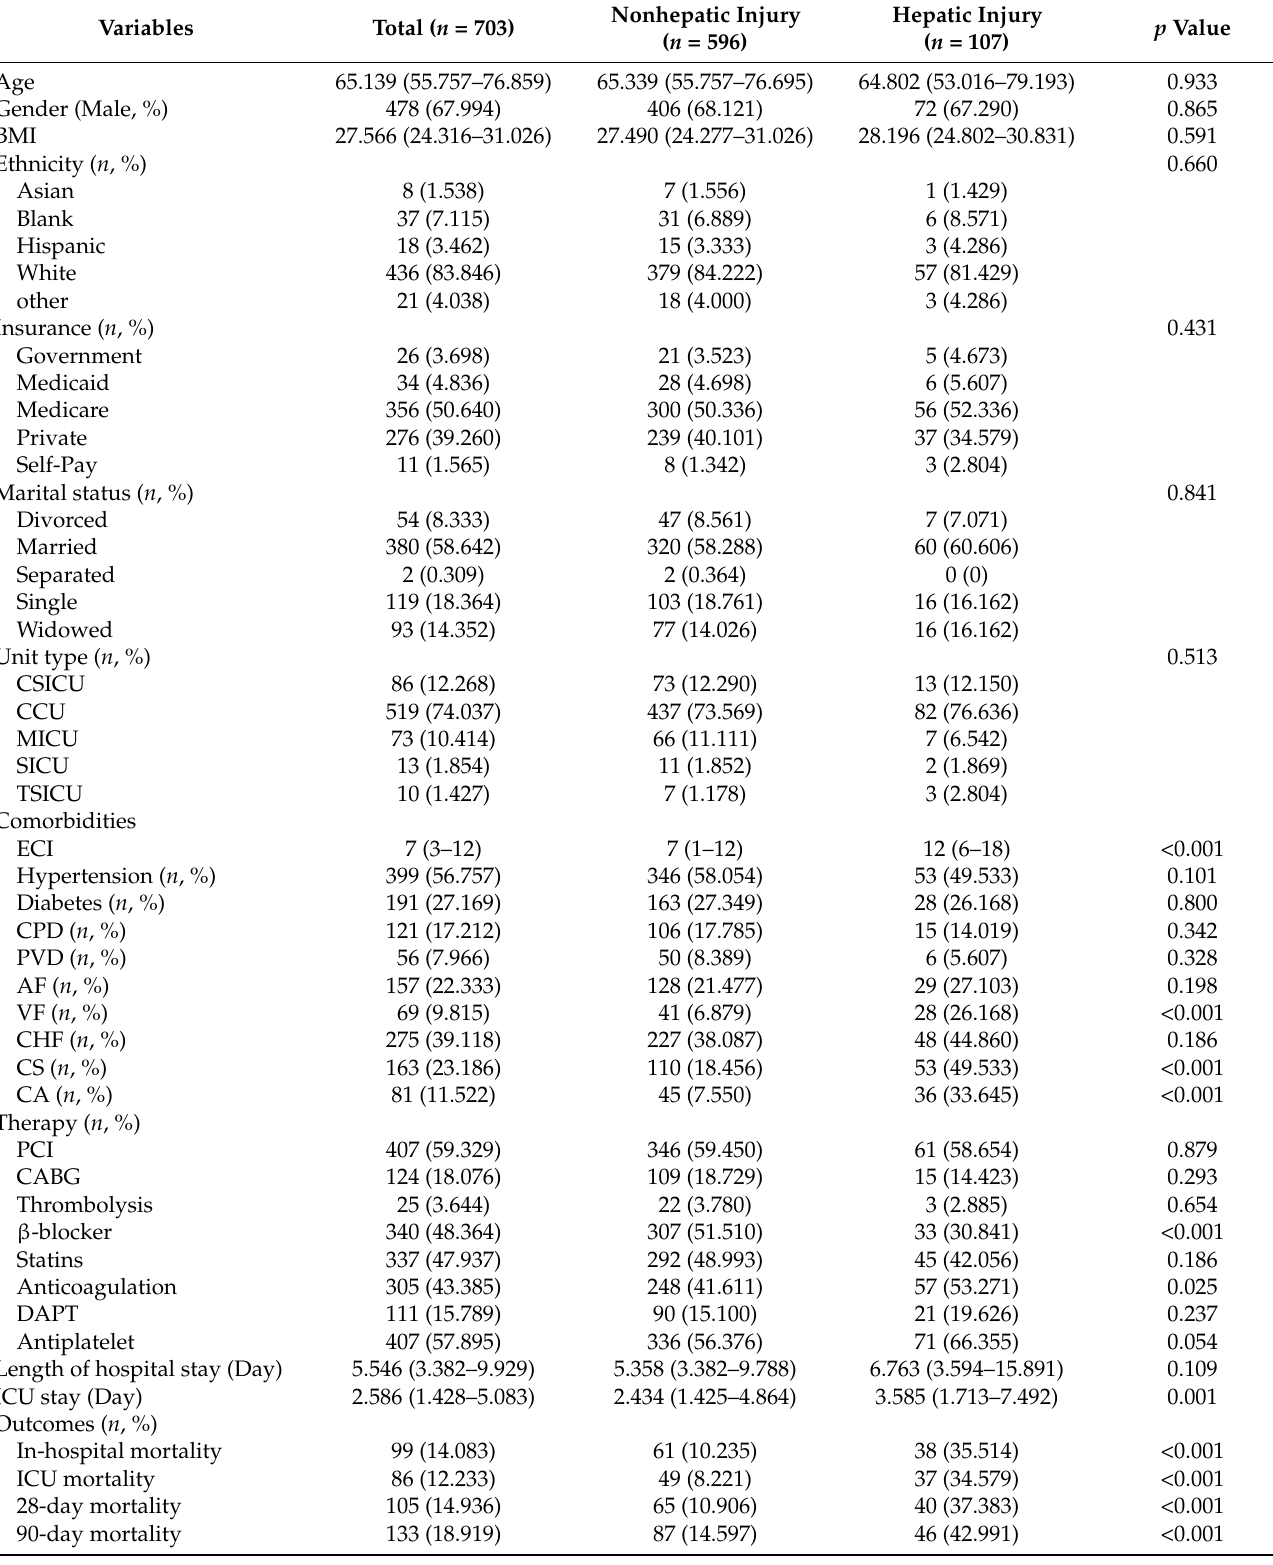
Table 1. Demographic and clinical characteristics of AMI patients stratified by acute hepatic